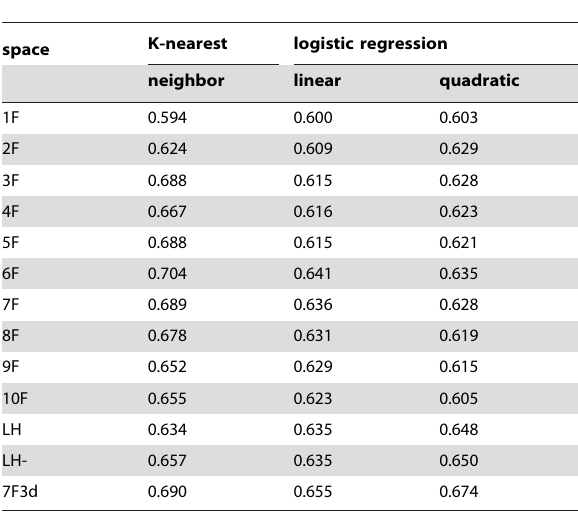
Table 2. Comparison of various prediction methods in terms of the area under the ROC curve